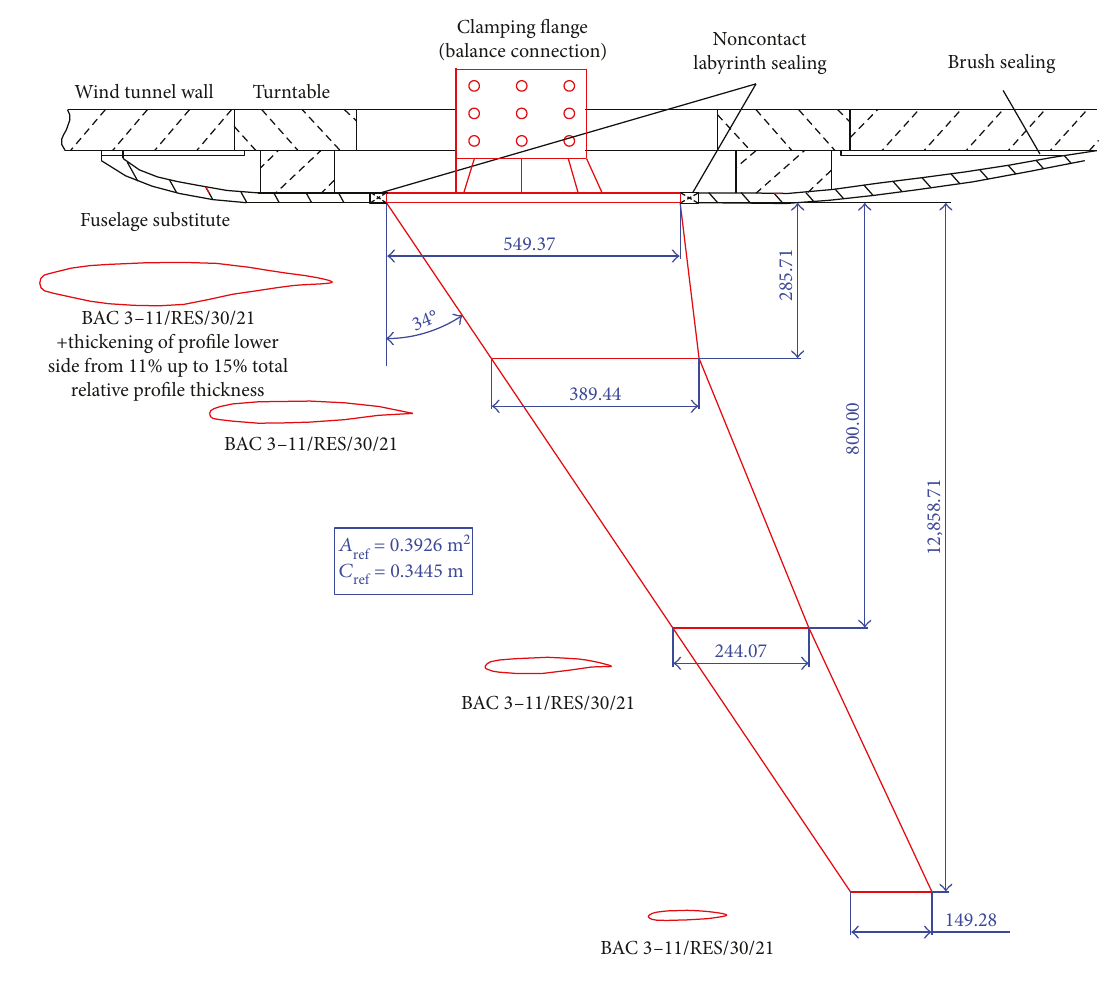
Figure 3: HIRENASD wing model planform. Table 1: The parameter list of the